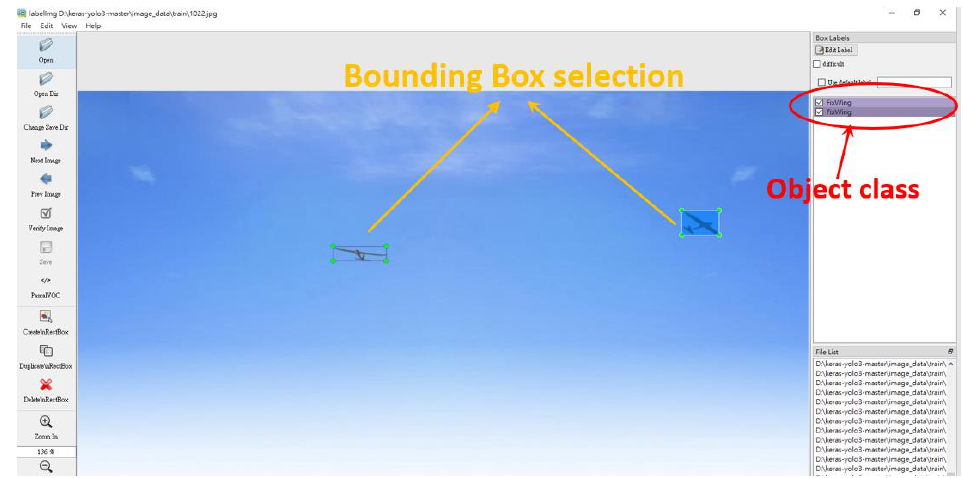
Figure 3. Labeling image of the training dataset.